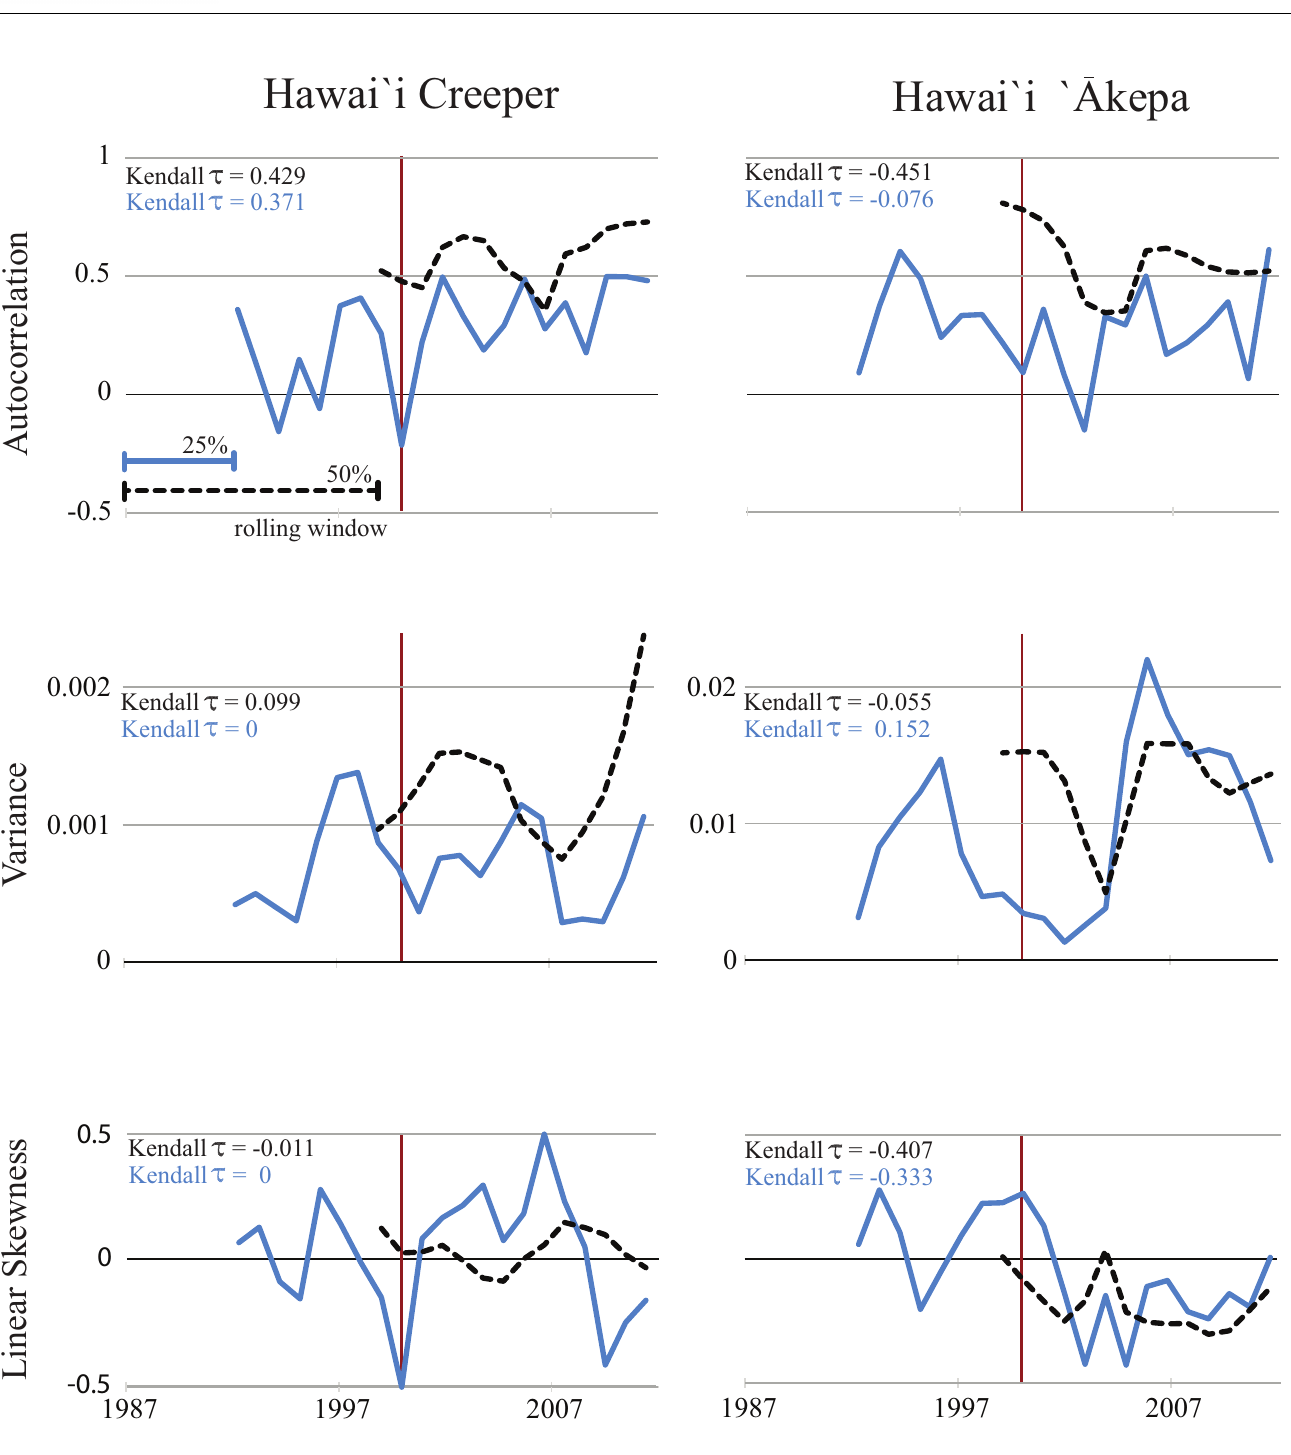
Fig 4. Autocorrelation, variance, and linear skewnesswith two rolling window sizes (complete 50% = black dashed line; complete 25% = blue solid line) for the Hawai‘i Creeper and the Hawai‘i‘ Ā kepa. The vertical red line occurs at the year 2000, when the JapaneseWhite-eye population started increasing (see Fig 3). Kendall’s τ indicatesthe strength of trend in indicators along the time series (complete50% = black font, top; complete 25% = blue font,